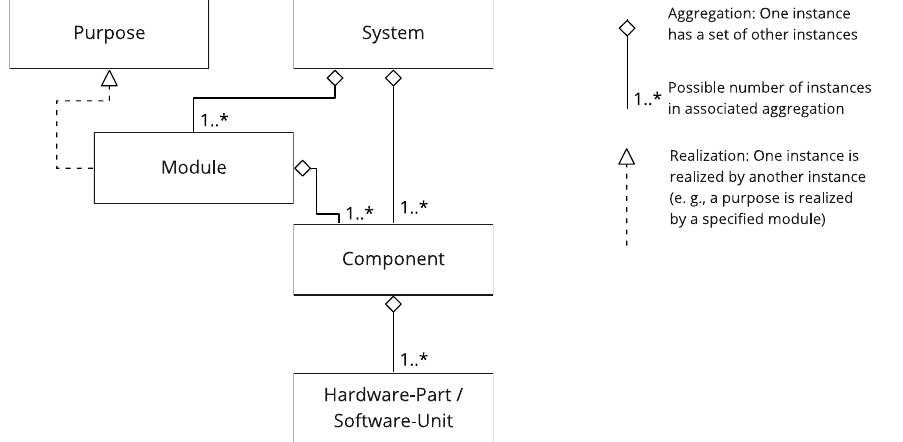
Figure 1. Relation between different hierarchical levels represented as a UML class diagram.